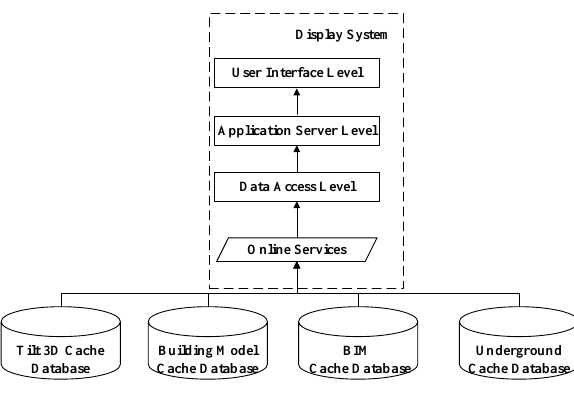
Figure 5 . Integrated Display of 3D City Modeling Data